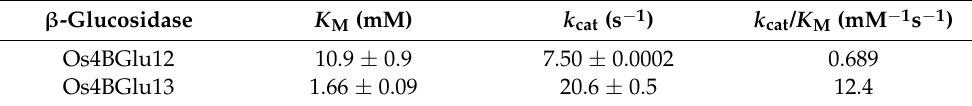
Table 2. Kinetic parameters of Os4BGlu12 and Os4BGlu13 for hydrolysis of ABA-GE. β